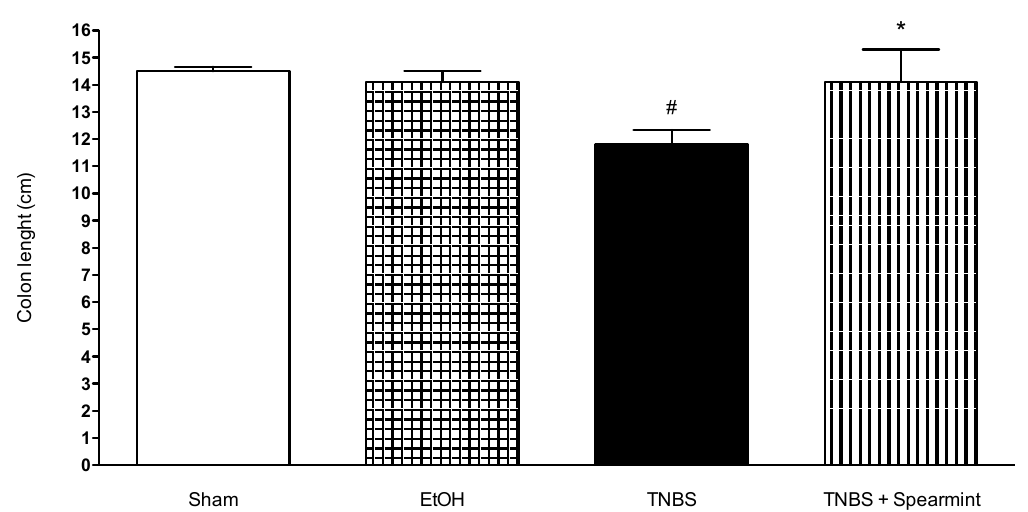
Figure 6. Effect of spearmint extract administration on colon length (cm). # p <0.001 vs Sham; * p <0.001 vs TNBS.